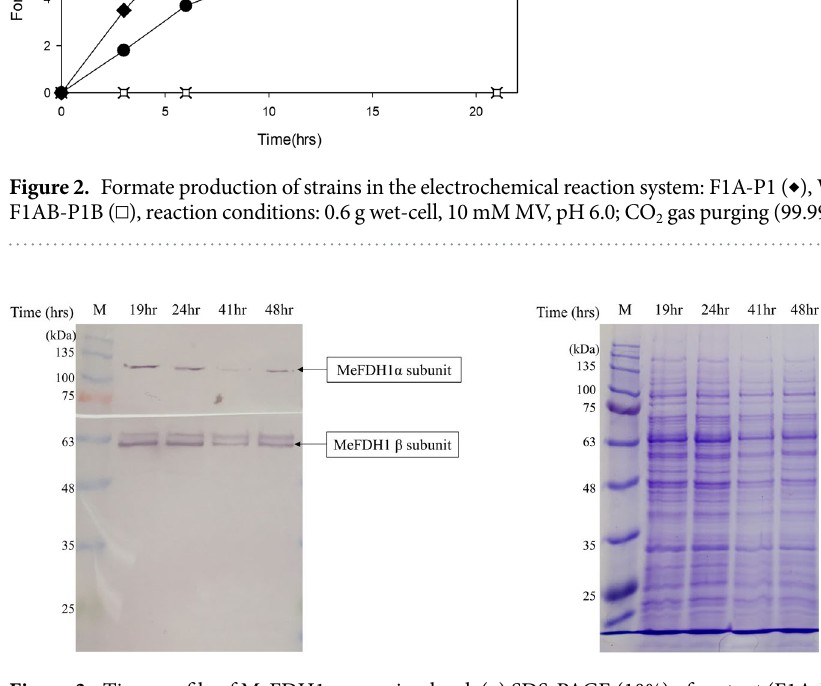
Figure 3. Time profile of MeFDH1 expression level. ( a ) SDS-PAGE (10%) of mutant (F1A-P1) crude extracts, ( b ) Western blotting of mutant (F1A-P1) crude extracts: protein marker (M), incubation times (19 hr, 24 hr, 41 hr, 48